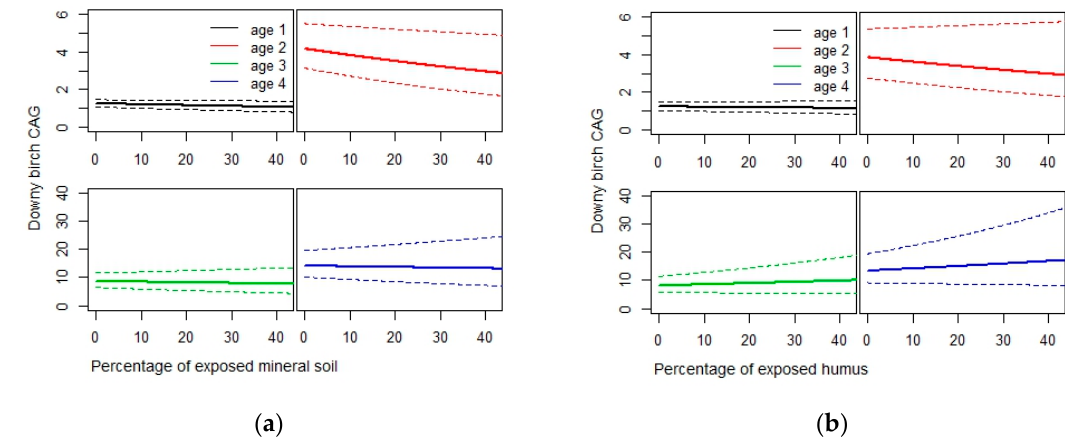
different scale on the Y-axis between age classes 1–2, 3–4, and 5.